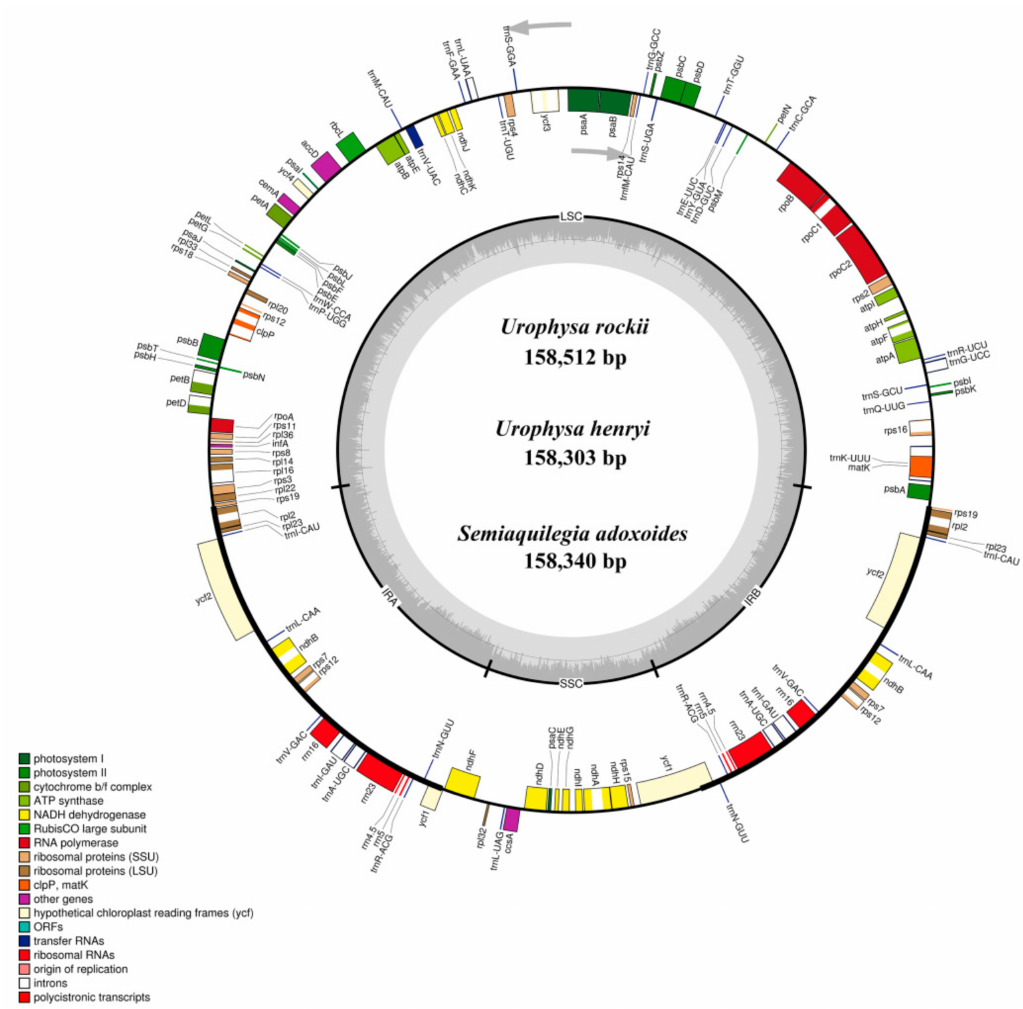
Figure 1. Gene maps of the Urophysa rockii , Urophysa henryi and Semiquilegia adoxoides chloroplast (cp) genomes. Genes shown inside the circle are transcribed clockwise, and those outside are transcribed counterclockwise. Genes belonging to different functional groups are color-coded. The darker gray color in the inner circle corresponds to the GC content, and the lighter gray color corresponds to the AT content. SSU: small subunit; LSU: large subunit; ORF: open reading